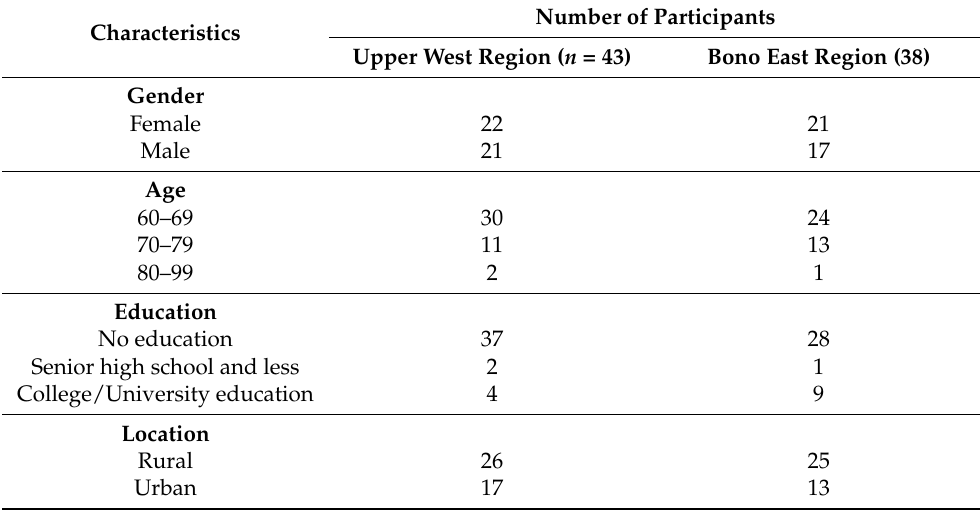
Table 2. Participants characteristics— sharing circles ( n =